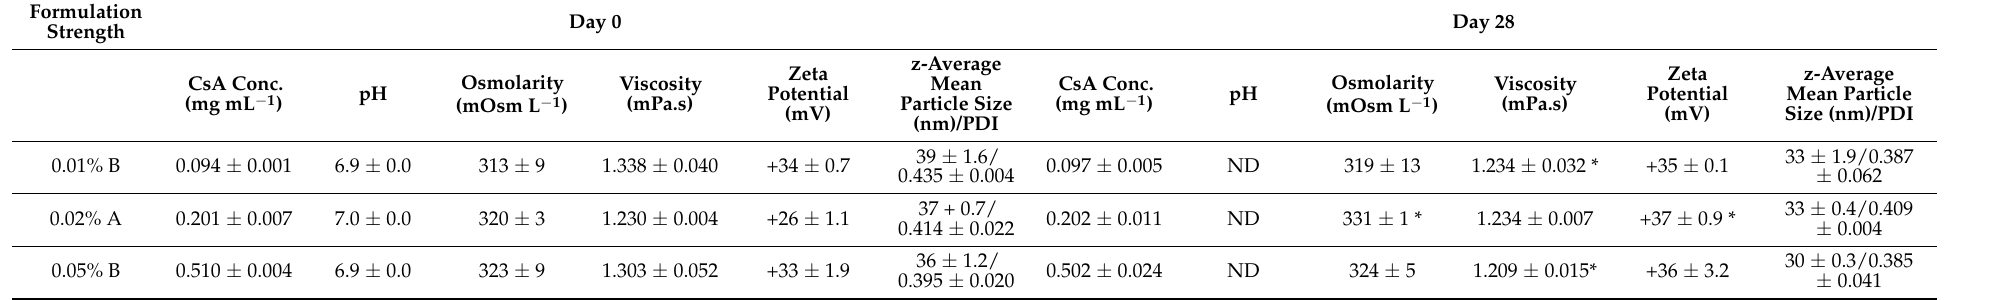
Table 5. NM133 Storage at Refrigeration Temperature (5–6 ◦ C), mean ± s.d. from three independent samples. Formulation